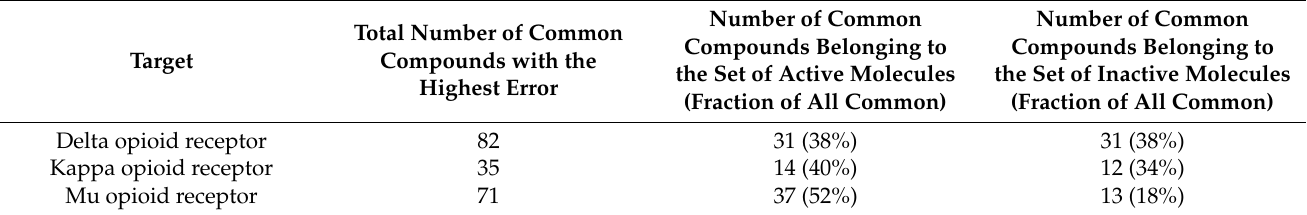
Table 2. Comparison of the common compounds with the highest prediction error belonging to the group of active and inactive compounds. Number of Common Number of Common Total Number of Common Compounds Belonging to Compounds Belonging to Target Compounds with the the Set of Active Molecules the Set of Inactive Molecules Highest Error (Fraction of All Common) (Fraction of All